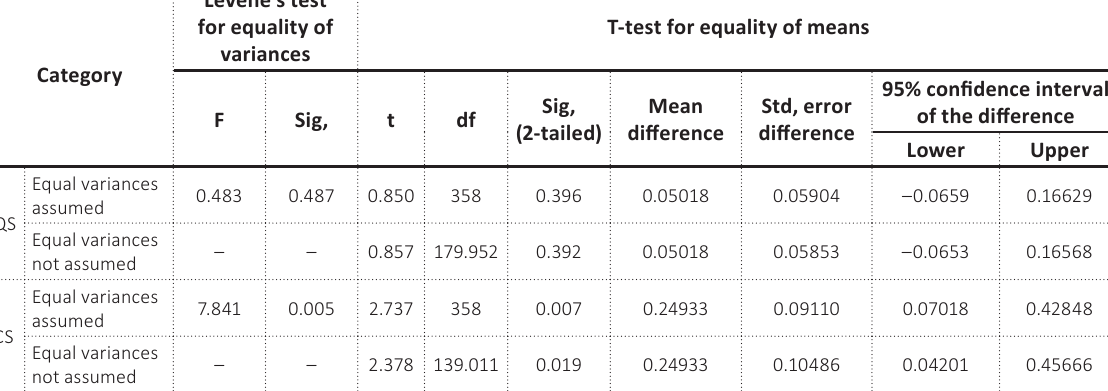
Table 8. T-test for quality of service and customer satisfaction according to the categorization of banks